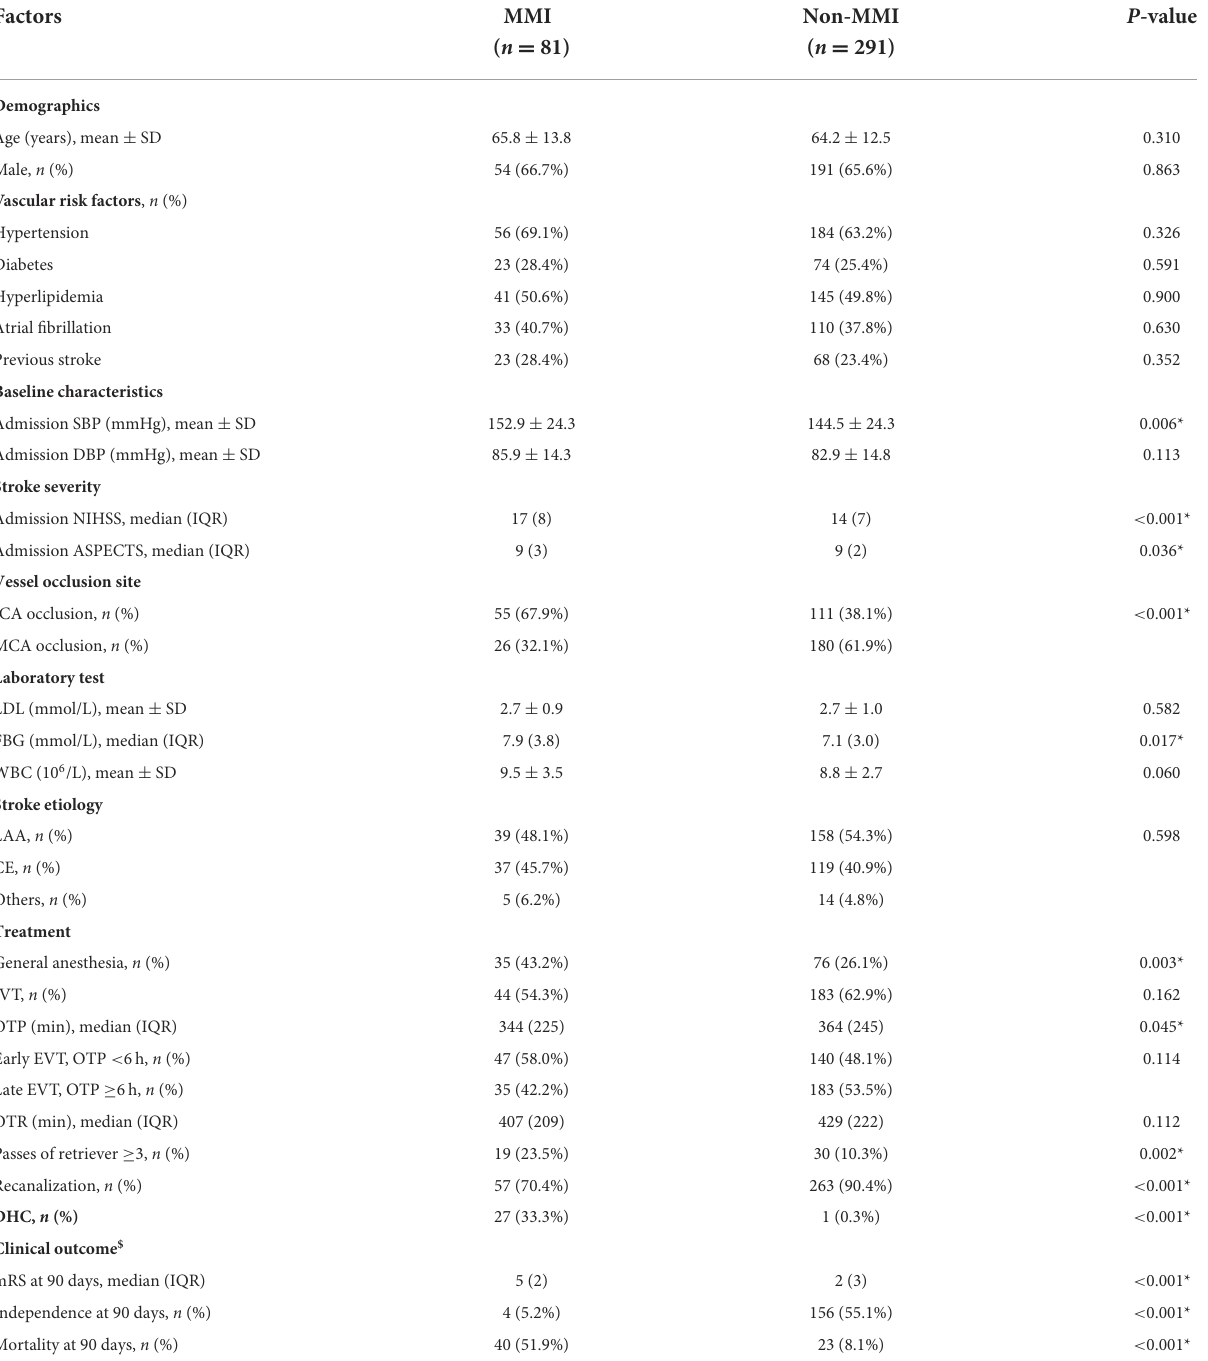
TABLE 2 Characteristics of patients with MMI and without MMI in the denervation cohort.